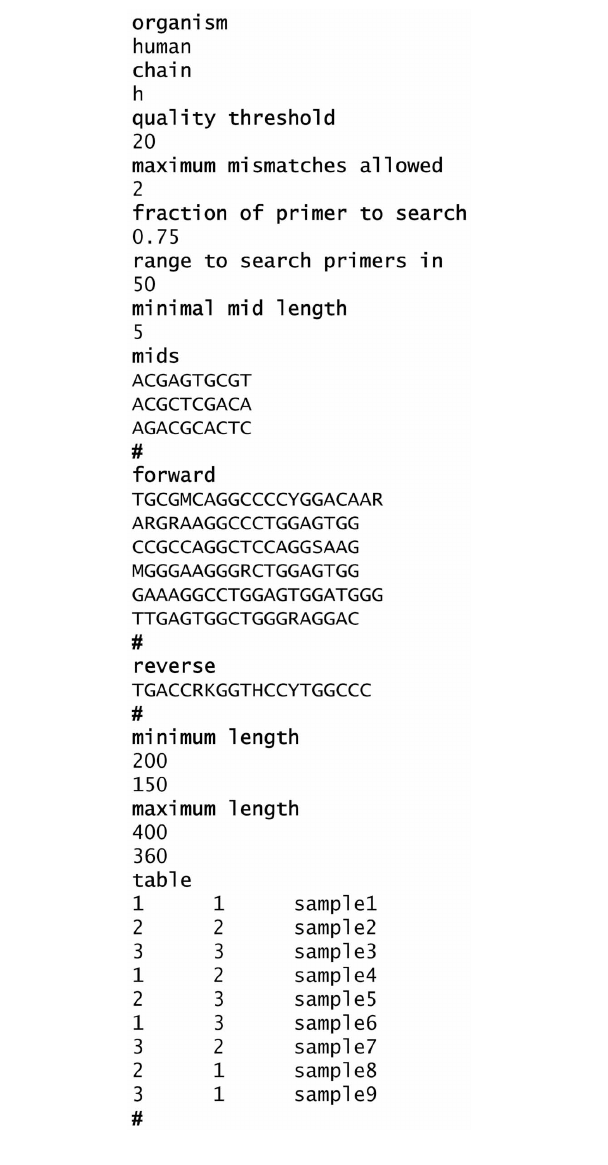
FIGURE 2 | An example of the input.txt file content. In bold- words/ characters that should always appear. Organism —represents the organism to which the sequences belong, “ Human ” in this example. Chain —represents the chain of the Ig (h, heavy as in this example; l, lambda; k, kappa). Quality threshold —the minimal average score for a sequence allowed. Maximum mismatches allowed —the number of mismatches the user allows when primers are being searched. “2” means that when primers are being searched, the sequence can contain 2 insertions/deletions or substitutions in the primer’s sequence. Fraction of primer to search —in case the full primer was not found, the program searches only the given fraction of the primer from the side closer to the gene. Range to search primers in —the search is executed on a limited range of bases at the ends of the read. Minimal MID length —in case the full MID was not found, the program searches for a perfect match of the minimal length of the MID from the side closer to the gene. Mids —a list of the MID tags that have been used in the current sequencing. The program automatically numbers the MID tags according to the insertion order. At the end of each list, a “ # ” should appear, see example. In case no